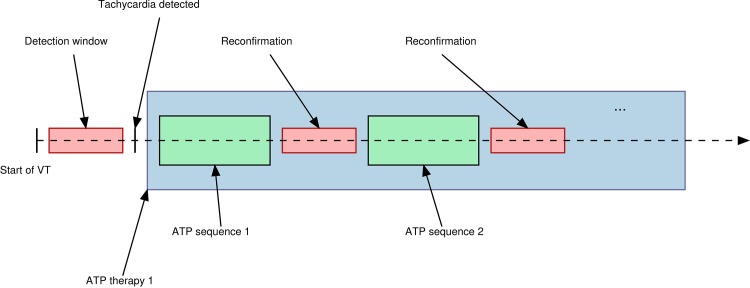
Schema of an ATP therapy.